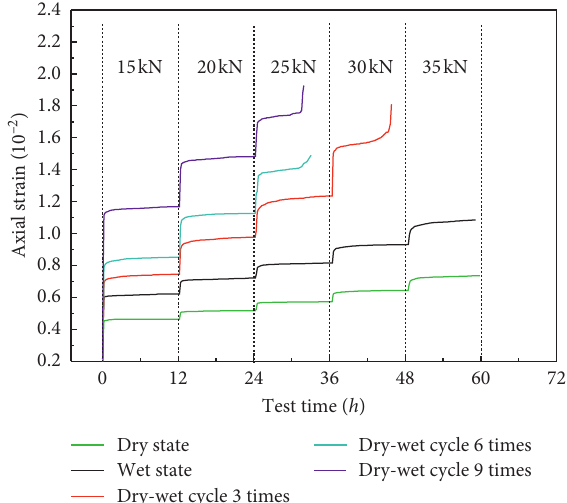
Figure 9: Uniaxial compression creep test curves of the red sandstone under different dry-wet cycles.